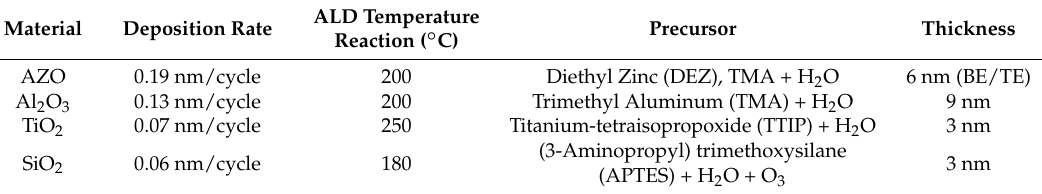
Table 2. The different deposited materials are listed, indicating the average deposition rate of each material deposited per atomic layer deposition (ALD) cycle, the chamber temperature during the cycles, the precursor used, as well as the estimated layer thickness for each material. The deposition rates for aluminum-doped zinc oxide (AZO) and alumina have been extracted from the work of [4], while those values for TiO 2 and SiO 2 are obtained from the works of [32,33], respectively. BE—bottom electrode; TE—top electrode.